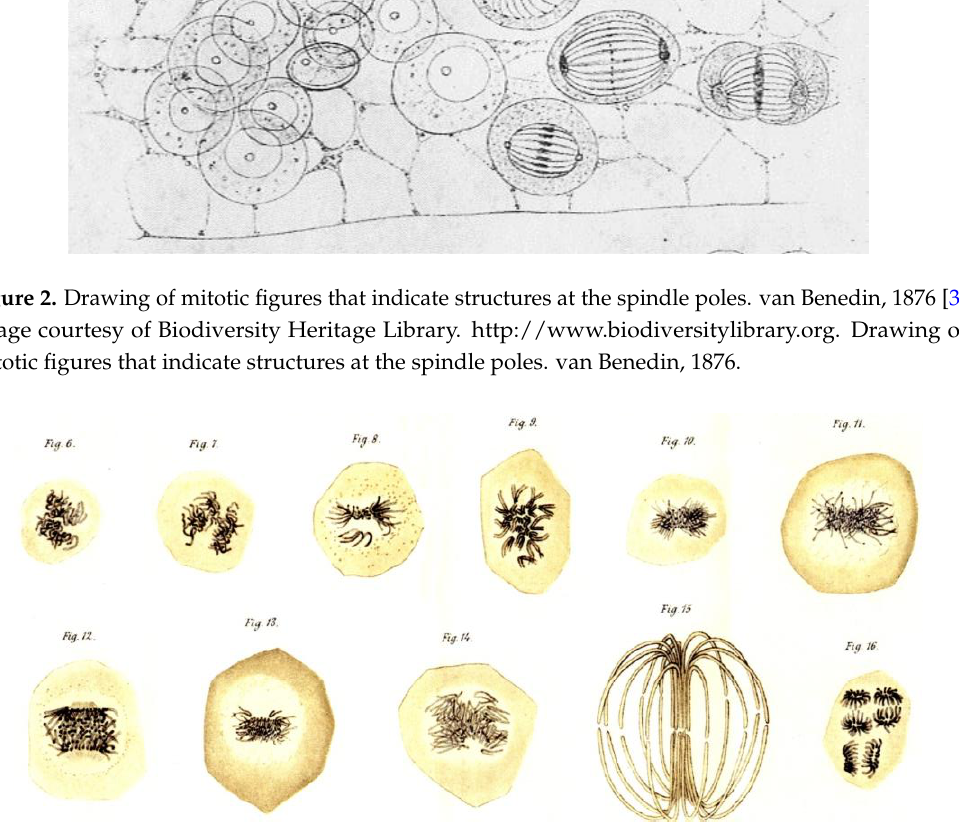
Figure 3. Drawings of mitotic figures by Flemming, 1878 [4,5]. This image is displayed under the